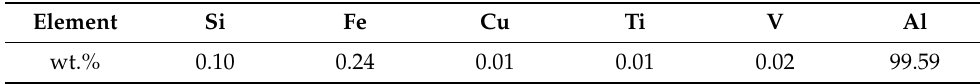
Table 2. Chemical composition of A1050 used in this